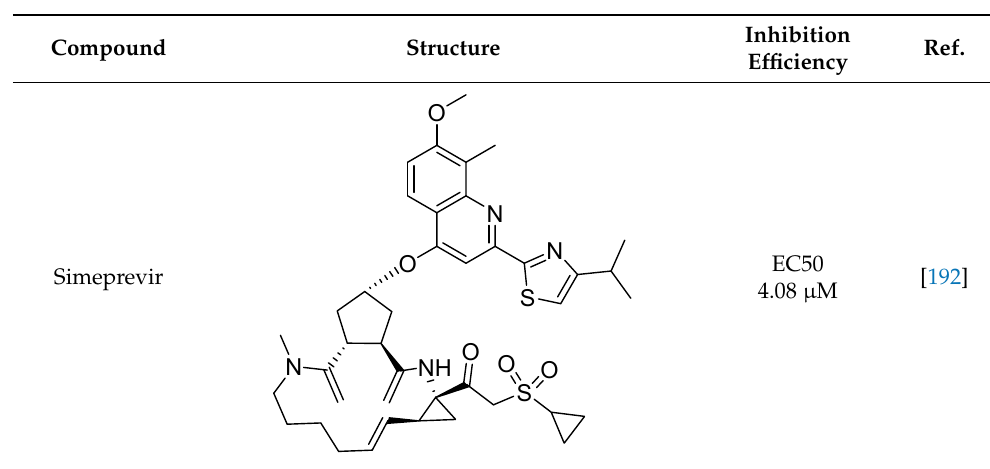
Table 4. List of coronavirus assembly inhibitors.